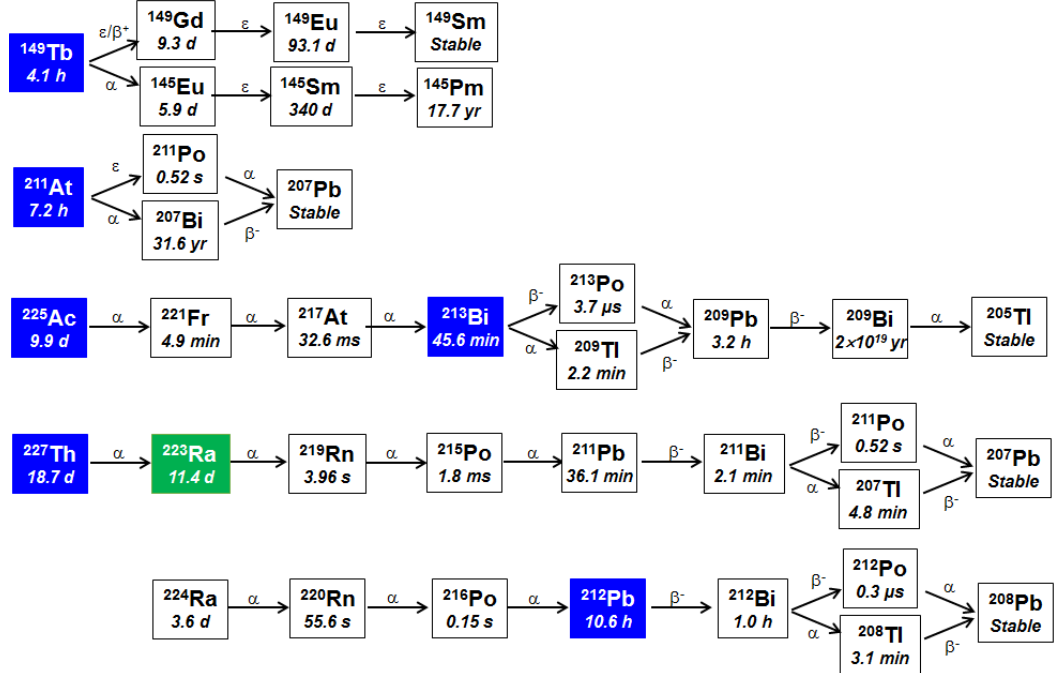
Figure 2. Simplified decay chains of 149 Tb, 211 At, 225 Ac, 227 Th, 223 Ra, and 224 Ra radionuclides. α–alpha particle, β–beta particle, β − –electron, β + –positron, ε–electron capture. Information extracted from the National Nuclear Data Center database, Brookhaven National Laboratory [75].